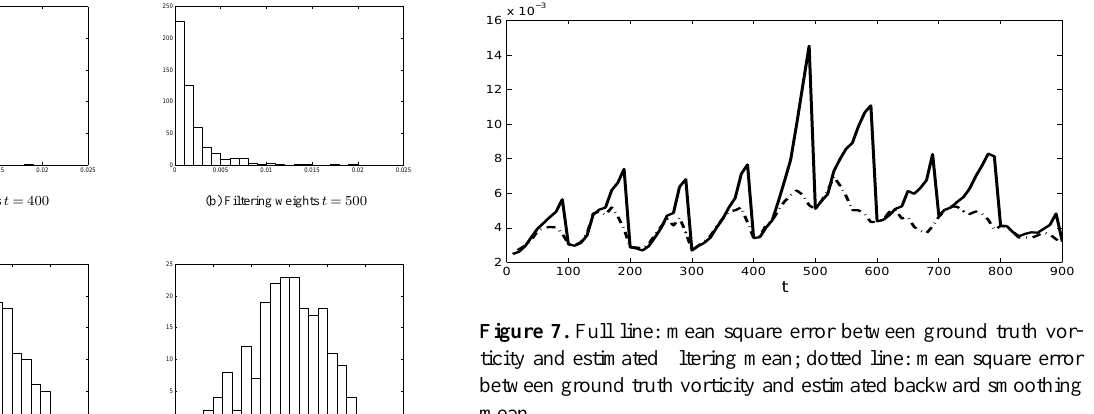
Fig. 6: Filtering and conditional simulation weights